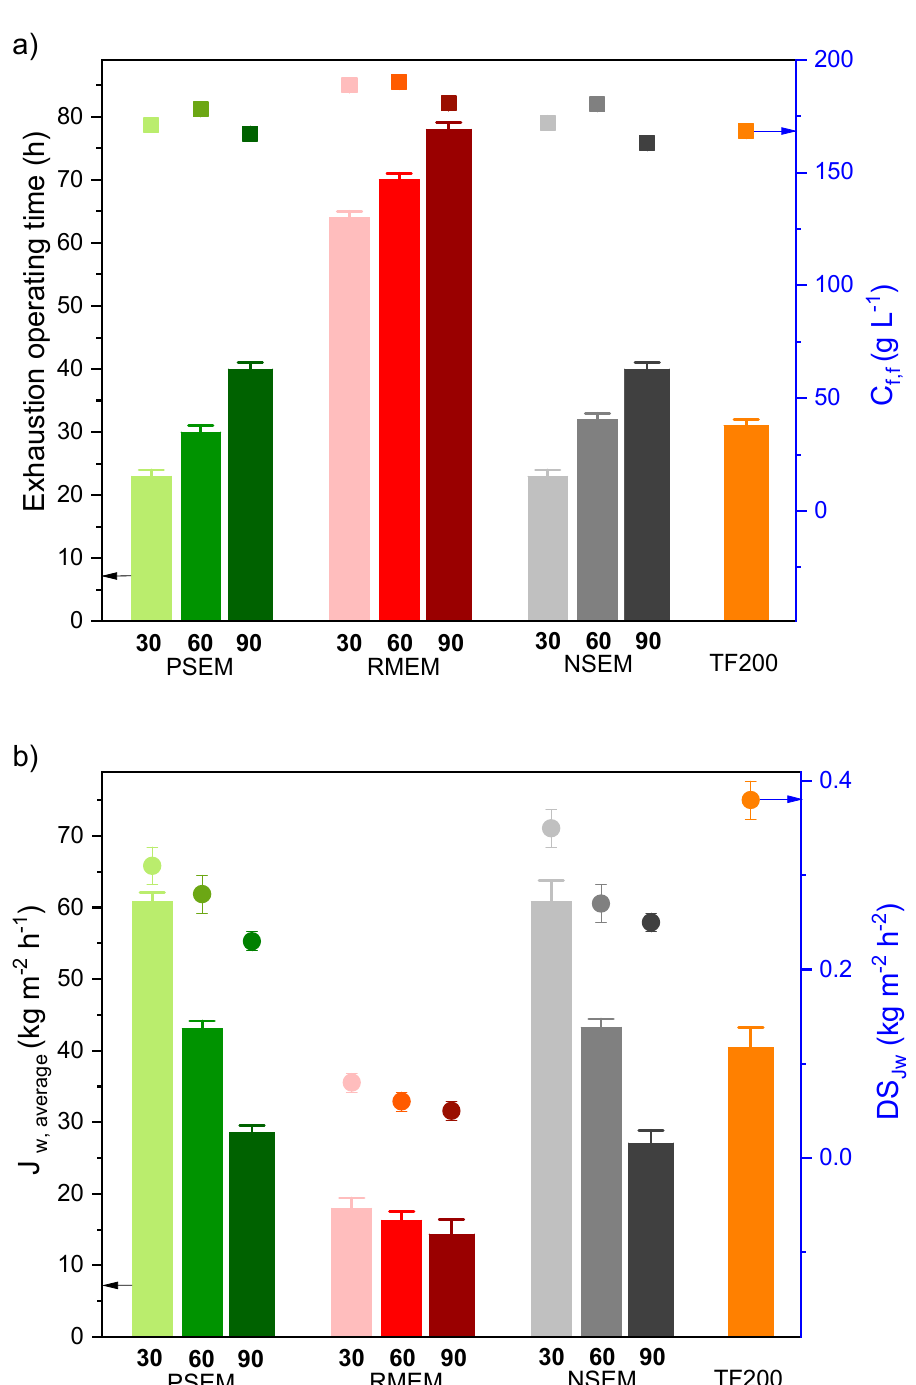
Figure 7. Long-term DCMD exhaustion test of the unsupported, NSEM, the supported electrospun nanofibrous membranes, PSEM and RMEM, and the commercial membrane TF220: ( a ) operating time (vertical bar) and final feed salt concentration ( C f,f , symbols) ( b ) average permeate flux ( J w, average , vertical bars) and decay slope of the permeate flux ( DS Jw , symbols). Experimental conditions: T f = 80 ◦ C, T p = 20 ◦ C, A m = 1.26 × 10 − 3 m 2 , feed and permeate flow rate fixed at 0.8 L min − 1 , distilled water as permeate and initial C f at 65 g L − 1 .